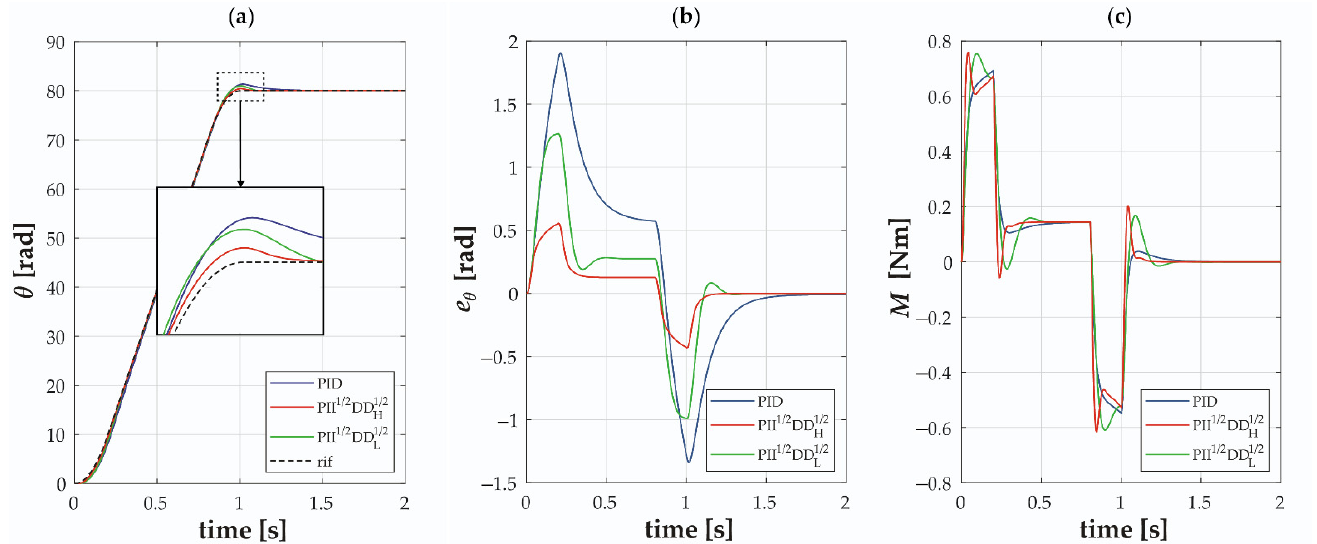
Figure 10. Trapezoidal speed law response, discrete-time simulation: angle θ ( a ), error e θ ( b ) and motor torque M ( c ); PID: blue; PII 1/2 DD 1/2 H : red; PII 1/2 DD 1/2 L : green; set-point: black.